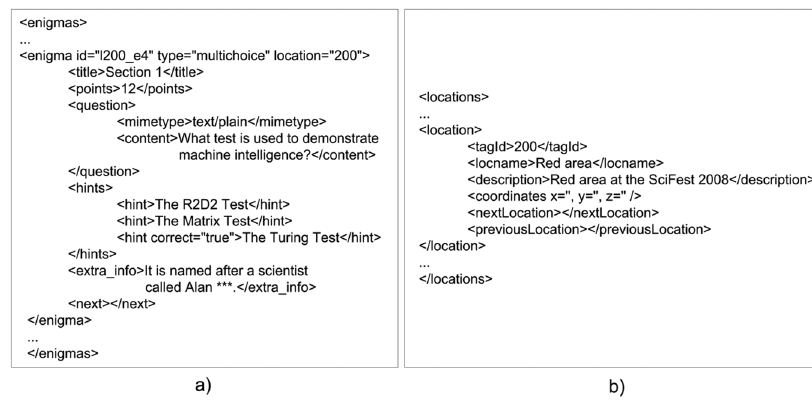
Figure 5. XML representations of an enigma (a) and a location